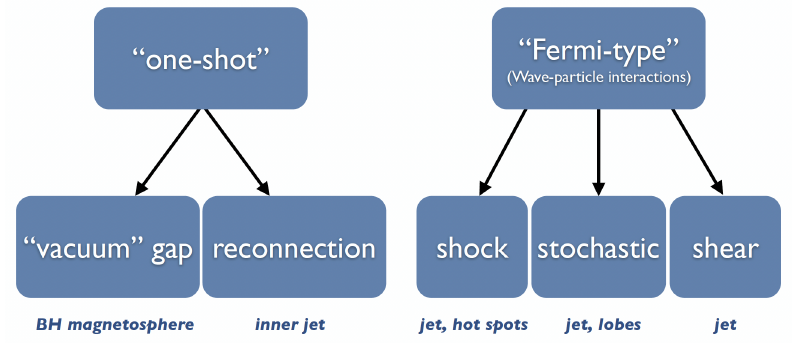
Figure 10. Possible acceleration mechanisms and preferred sites in AGNs (not exhaustive). Sometimes the processes could be intertwined, e.g., reconnection could also be a driver for part of the turbulence required for stochastic